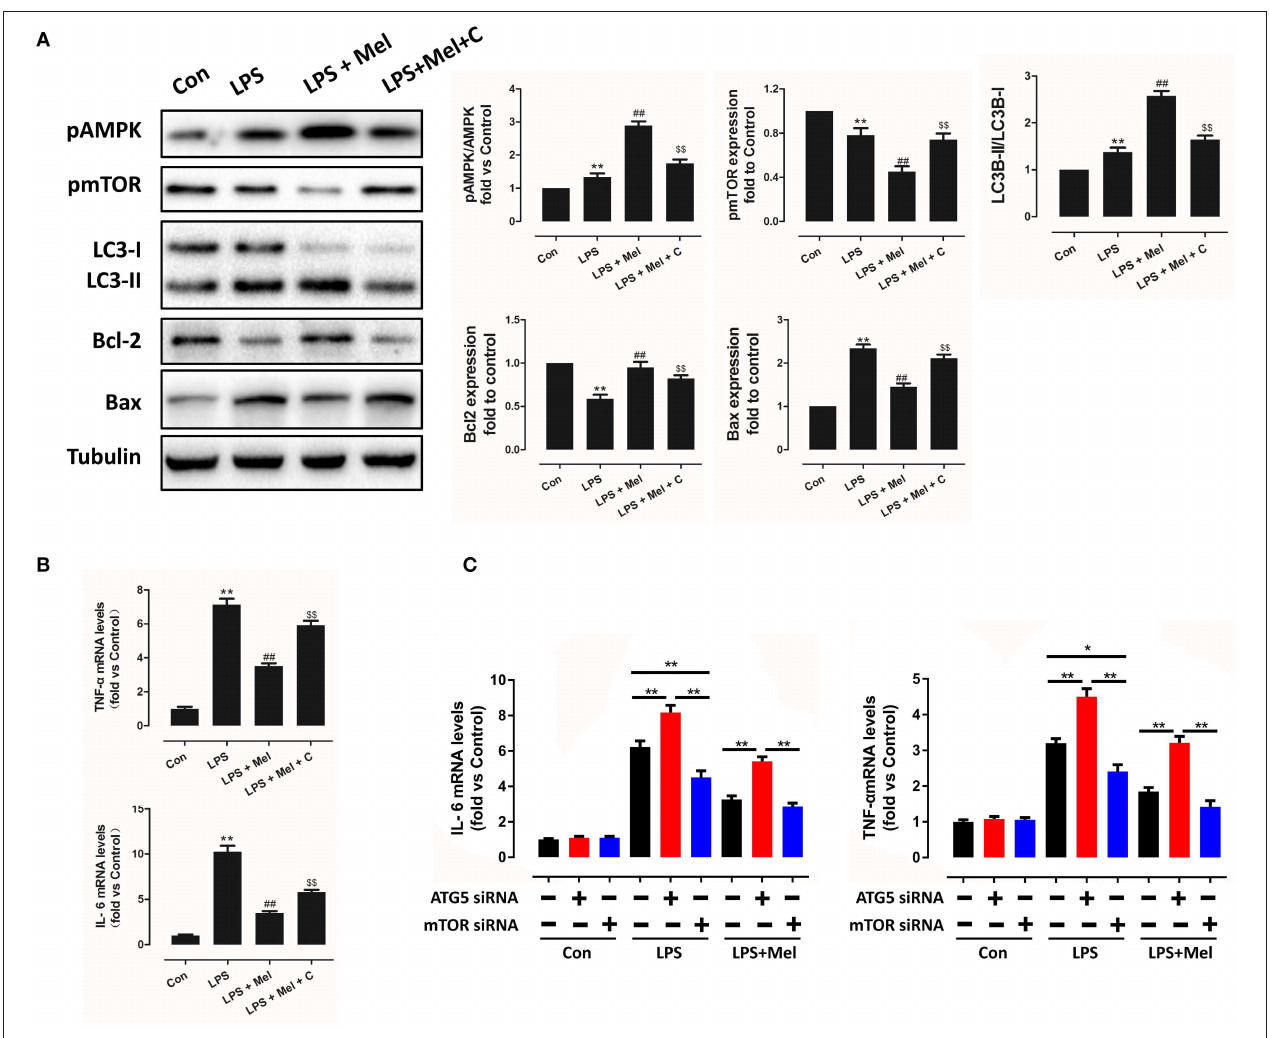
FIGURE 10 | Melatonin reversed LPS-induced inflammation and reduced apoptosis through the AMPK/mTOR/autophagy pathway, which can be abolished by Compound C treatment in vitro . (A) Representative bands and quantitative analysis of pAMPK phosphorylation levels, pmTOR phosphorylation levels, LC3B-II/ LC3B-I ratio, Bcl-2 expression and Bax expression. (B) Cell IL-6 mRNA levels and cell TNF- α mRNA levels. n = 6, ** P < 0.05 vs. the Control group, ## P < 0.05 vs. the LPS group, $$ P < 0.05 vs. the LPS + melatonin group. (C) Cell IL-6 mRNA levels and cell TNF- α mRNA levels, n = 6. * P < 0.05, ** P <